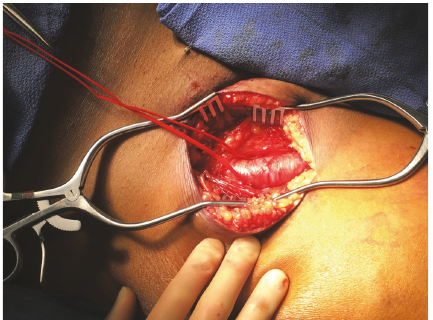
Figure 5: A superficial femoral artery cutdown was performed revealing an enlarged SFA.